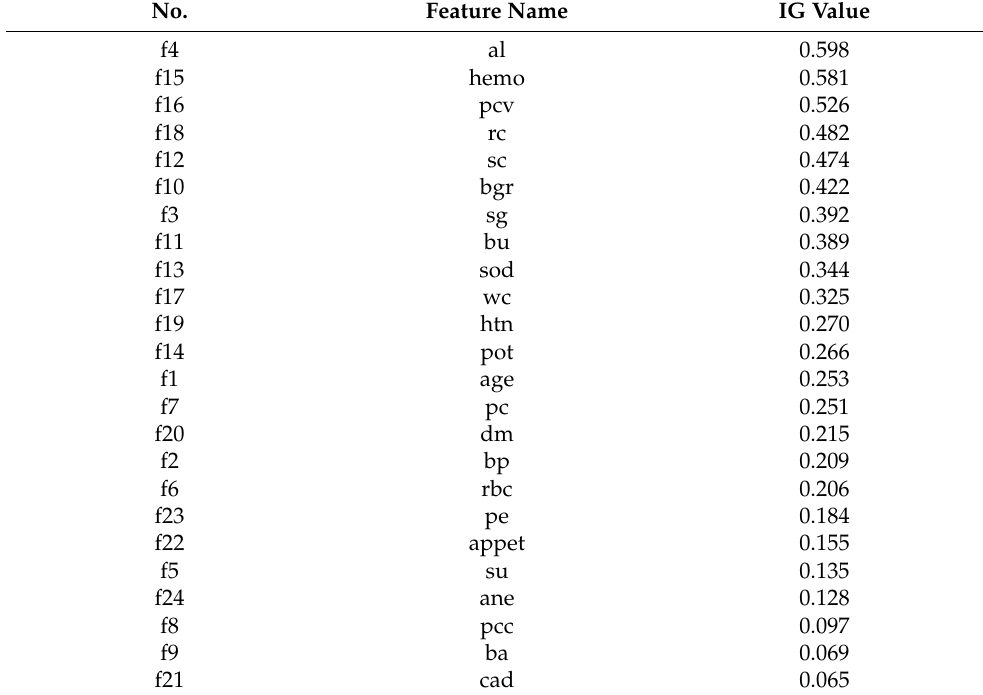
Table 3. Feature ranking.